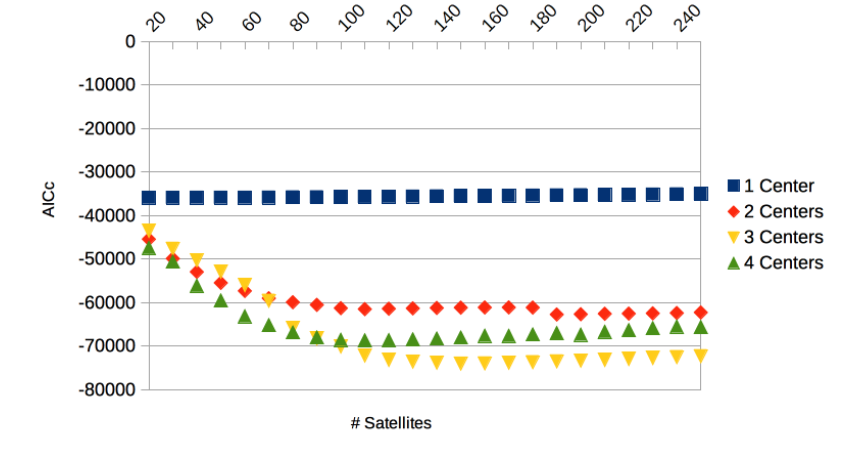
Figure 13. Akaike information criterion corrected for finite sample sizes (AICc) for CMU 86 Trial 1 with 1, 2, 3, and 4 centers and varying numbers of satellites. The global optimum was reached for three centers and 150